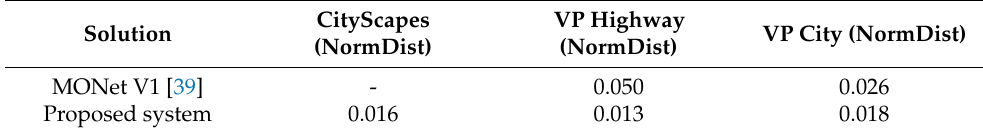
Table 4. Vanishing point